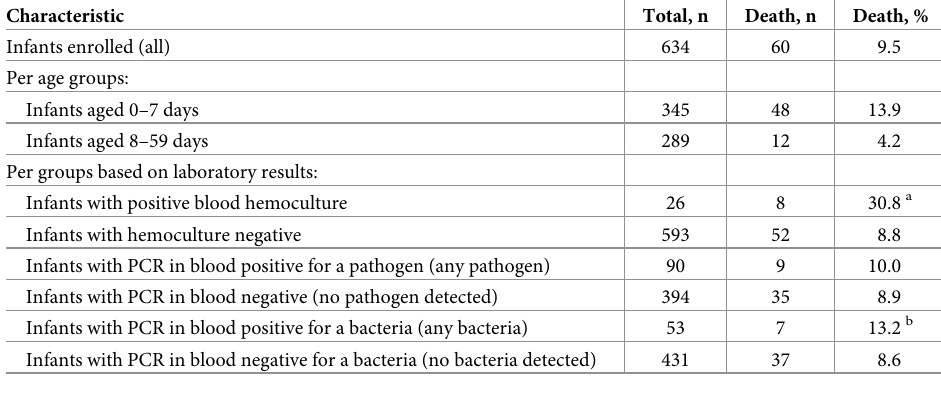
Mortality rate in infants with clinical suspicion of invasive infection Among 634 infants enrolled, 60 (9.5%) died, the majority (48/60, 80%) in the youngest age